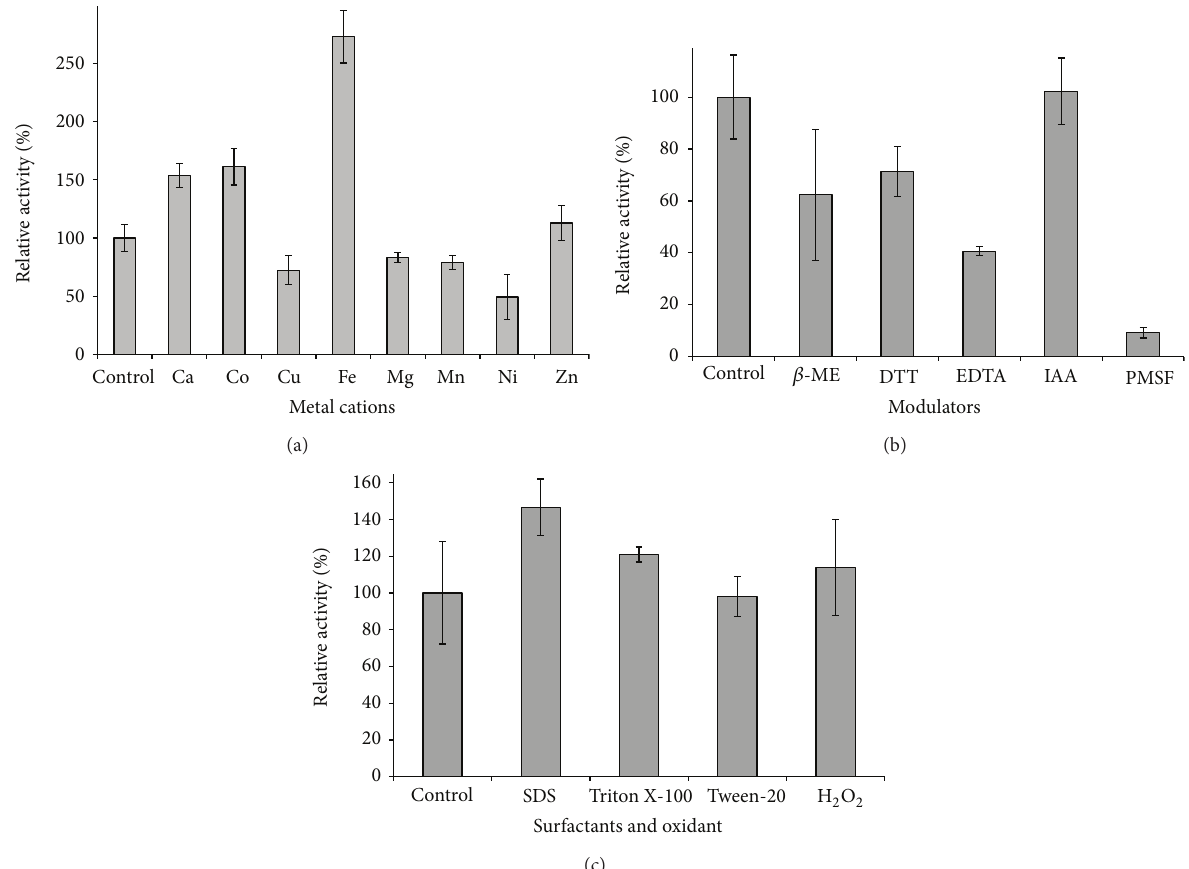
Figure 4: Effect of additives on activity. (a) Activity of protease after incubation with various metal cations. (b) Activity of protease after incubation with various inhibitors. (c) Activity of protease after incubation with various surfactants and oxidants. All residual activities were assayed at 60 ∘ C and pH 9. Control reactions contain no